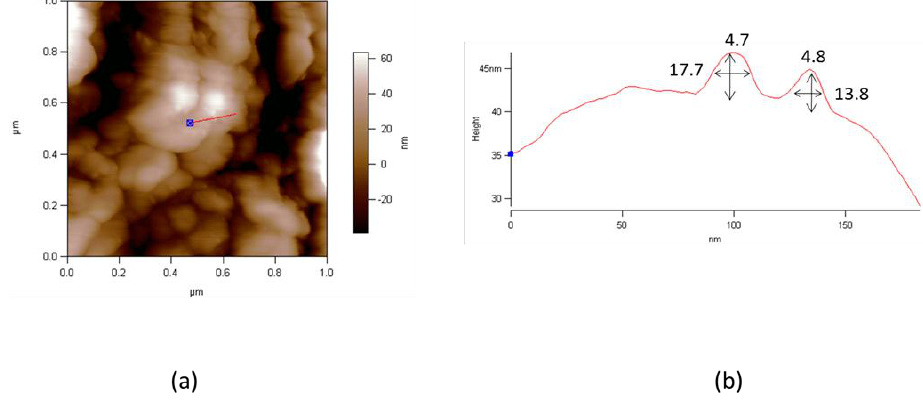
Figure 3. AFM photograph of a cross section of the solidified LSnanop, ( a ) superposition of geometrical imaging and phase one; and ( b ) height distribution along the red line from the blue spot in ( a